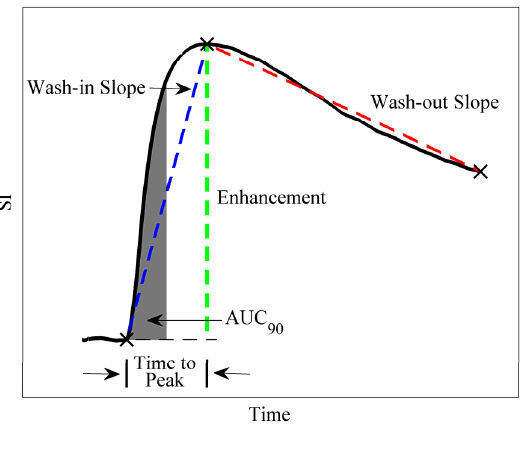
Figure 2. The figure depicts several parameters that are commonly explored in semi-quantitative DCE-MRI analysis. The black line shows a representative signal intensity curve. The gray shaded area indicates the initial area under the curve (AUC) for the first 90 s after injection of the contrast agent. The blue dashed line represents the wash-in slope and the red dashed line represents the wash-out slope. The green dashed line shows the enhancement. Finally, the bars between the arrows indicate the time to